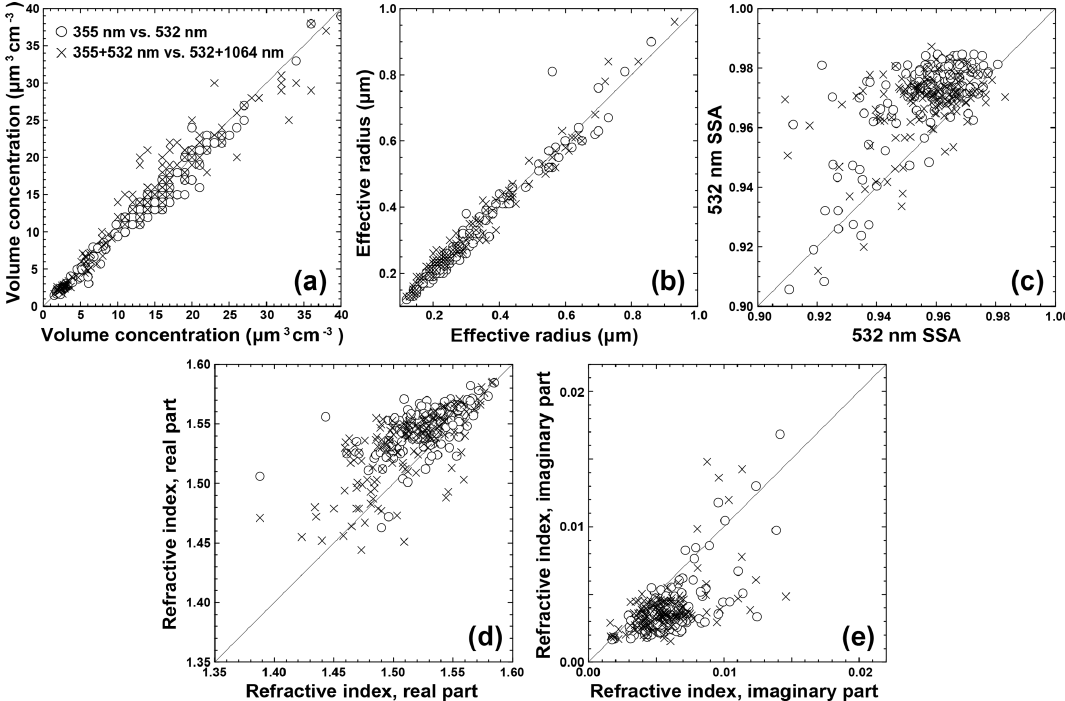
Figure 8. Correlation of (a) volume concentration, (b) effective radius, (c) 532nm SSA, and the (d) real and (e) imaginary part of the refractive index obtained from inversion runs, which use a single particle linear depolarization ratio at 355 or 532nm (3 + 2 + 1, circles) or two particle linear depolarization ratios at 355 and 532 or 532 and 1064nm (3 + 2 + 2, crosses) as input